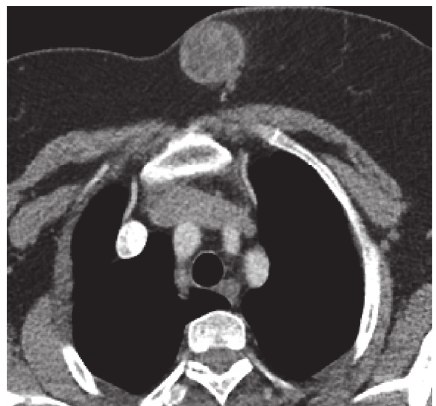
Figure 3: Axial contrast-enhanced thorax CT image. Hypodense, well-defined mass with capsular wall and internal septae, situated at the inner part of the left breast. The lesion shows capsular